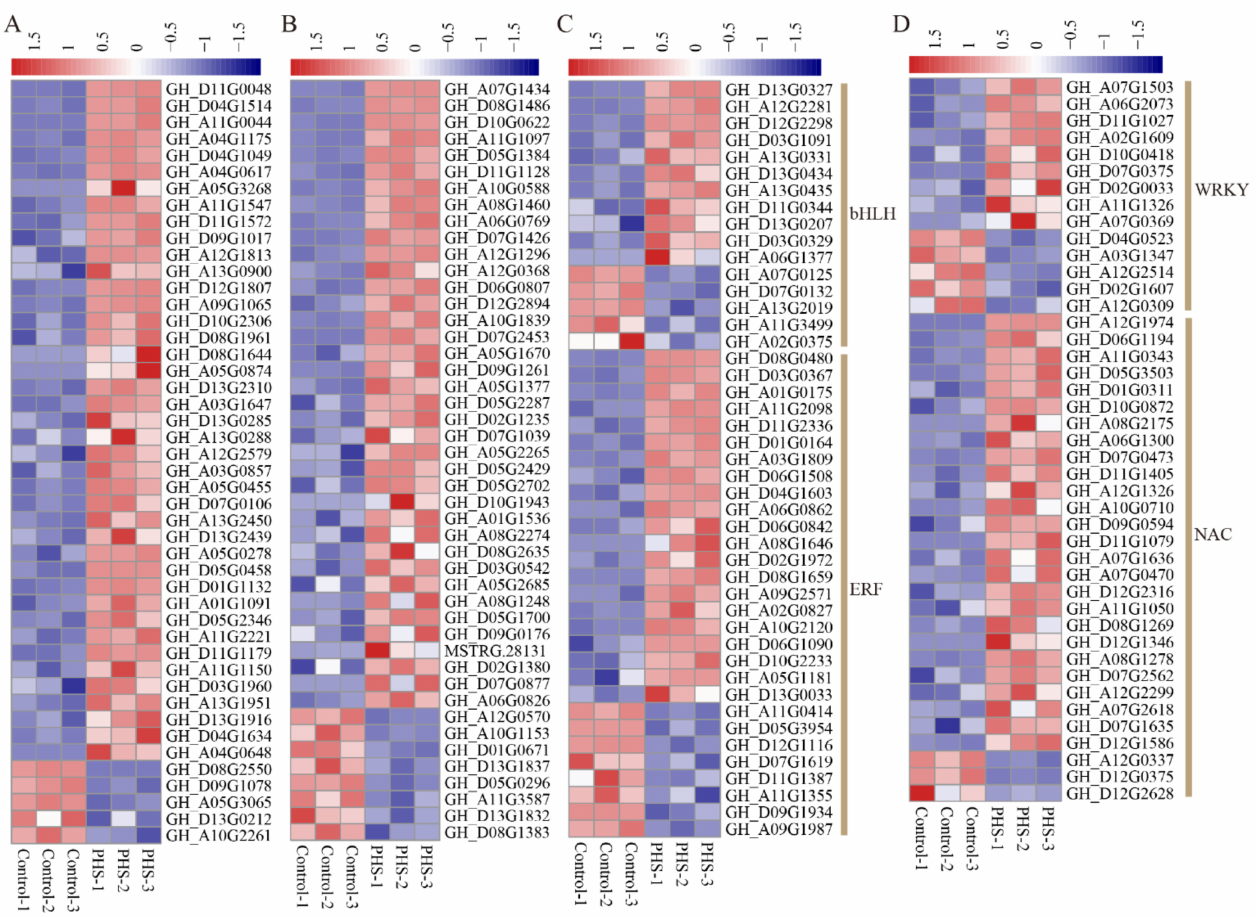
Figure 6. Heat map of differential expression of transcription factors in the control and PHS (t18:0, phytosphingosine)-treated samples cultured for 10 days. ( A ) Zinc finger. ( B ) MYB . ( C ) bHLH and ERF . ( D ) WRKY and NAC